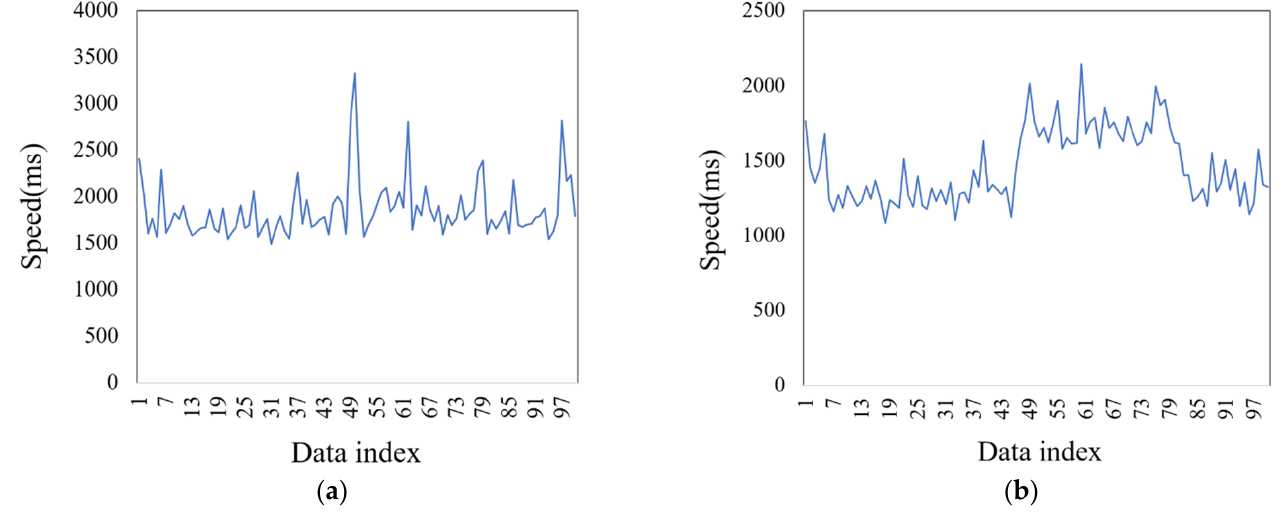
Figure 10. ( a ) Data upload speed through the system, ( b ) original data upload speed .